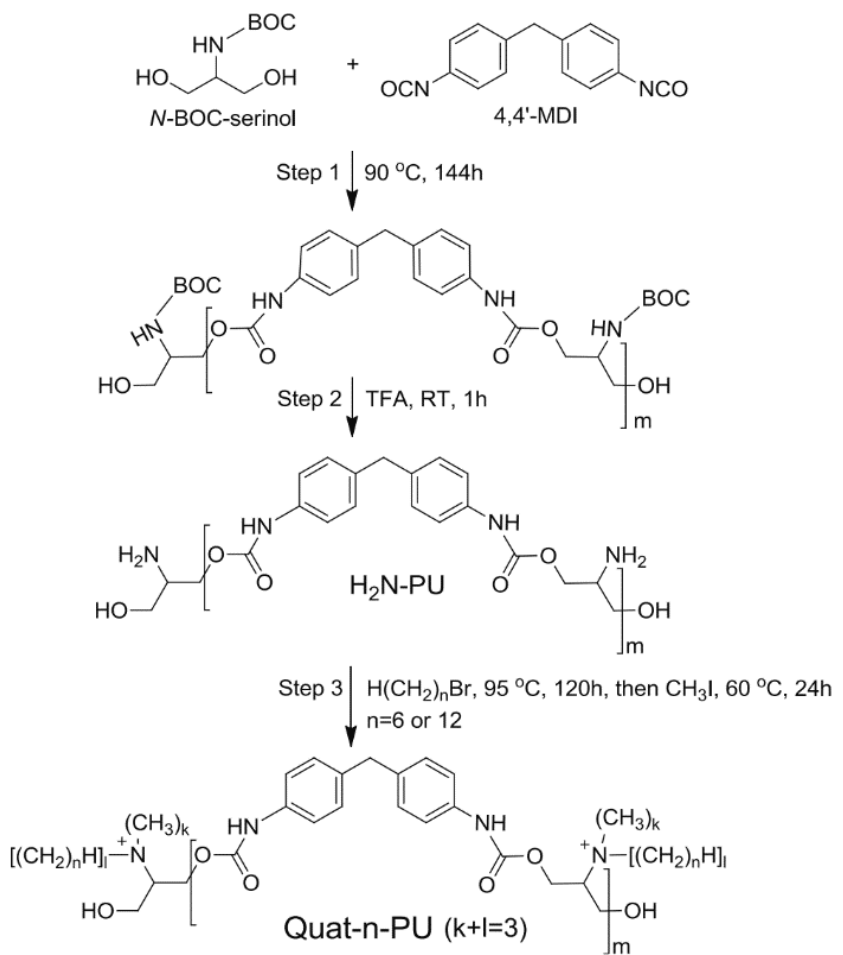
Figure 9. Synthesis of N , N -dodecylmethyl-polyurethane. Reprinted by permission from Springer,